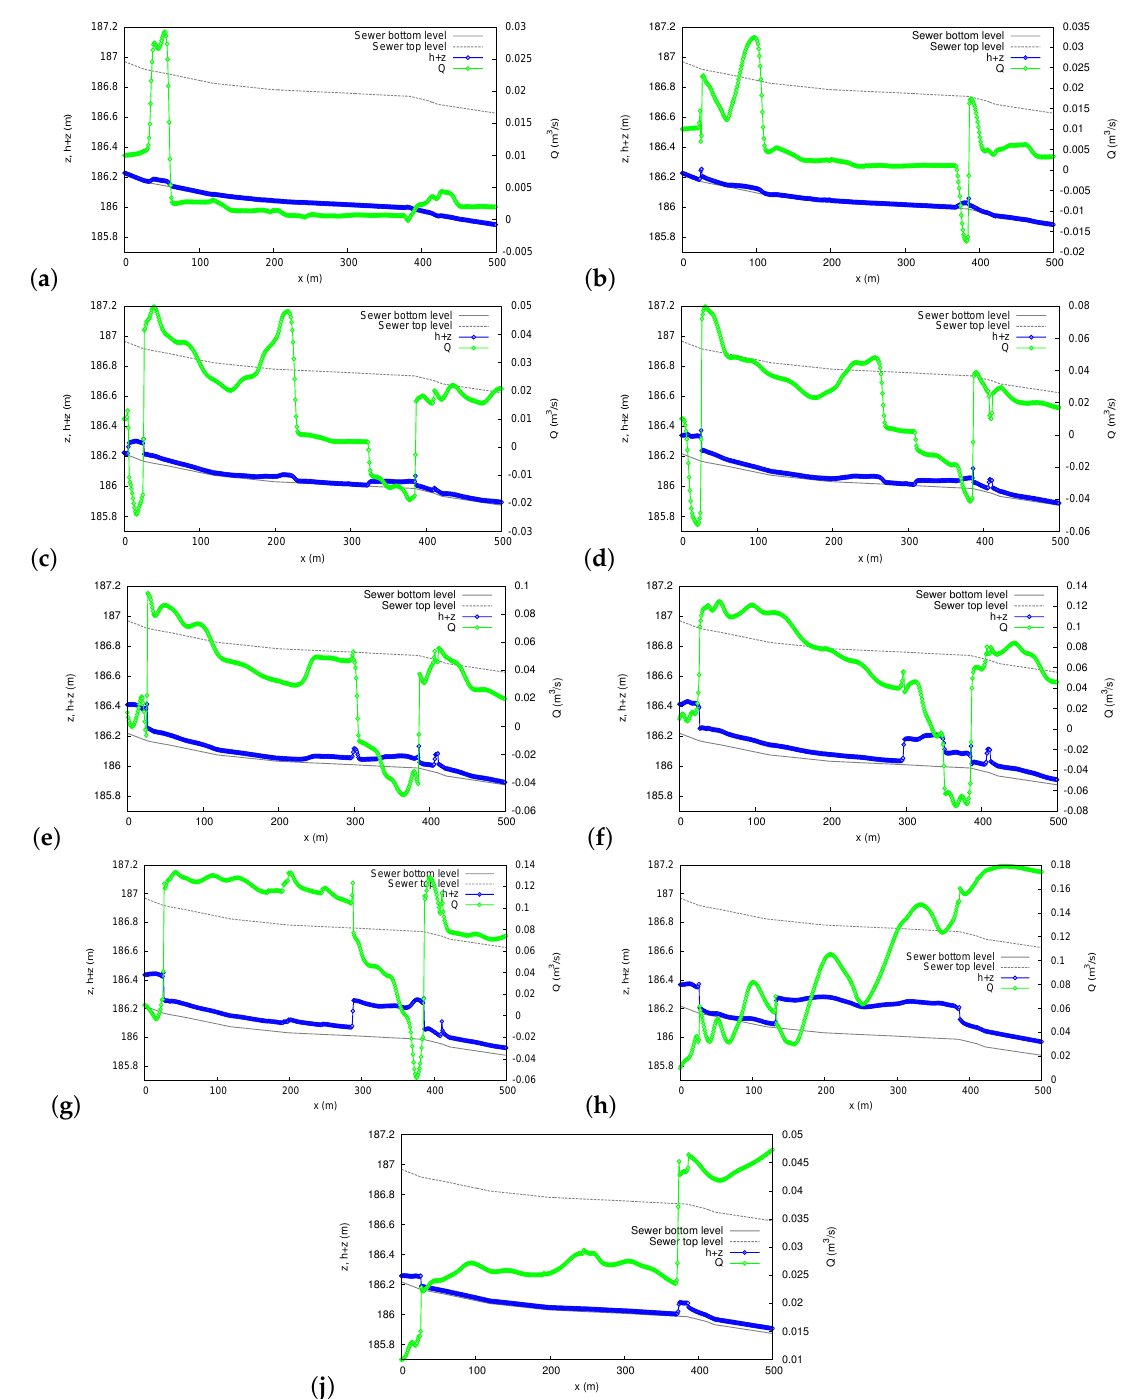
Figure 13. Case 2.1. Network profile at t = 50 s ( a ), 80 s ( b ), 150 s ( c ), 175 s ( d ), 200 s ( e ), 250 s ( f ), 300 s ( g ), 1000 s ( h ), and 2000 s ( j